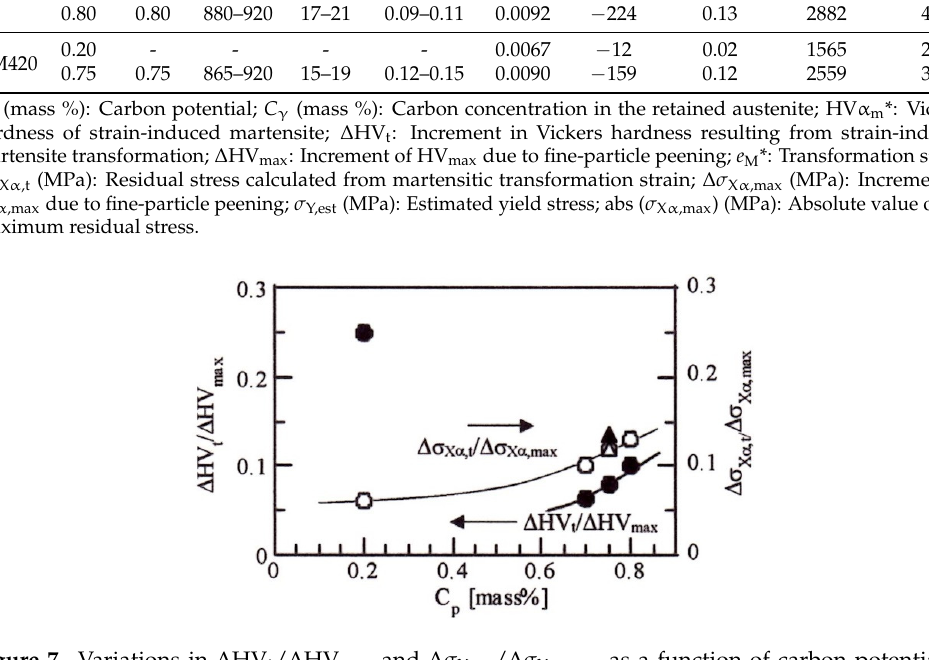
Figure 7. Variations in Δ HV t / Δ HV max and Δ σ X α ,t / Δ σ X α ,max as a function of carbon potential in vacuum ‐ carburization ( C P ) in TM ( ○ ● ) and SNCM420 ( Δ ▲ ) steels subjected to fine ‐ particle peening.